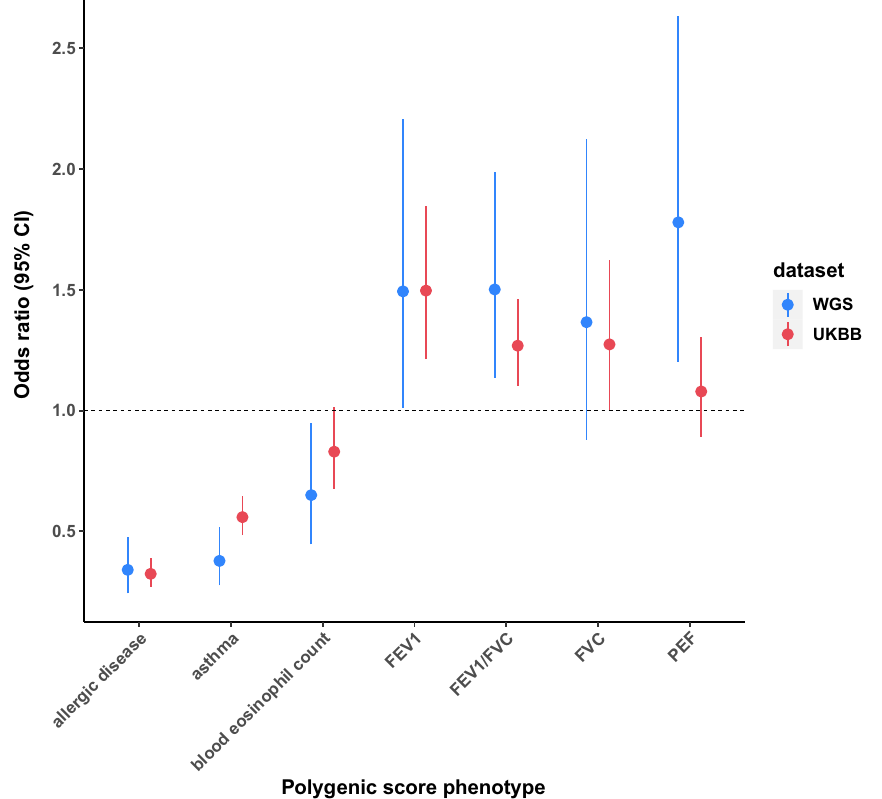
Figure 2. Association of polygenic scores with asthma age of onset. Childhood onset asthma was defined as age onset ≤ 12 and adult onset asthma was defined as age of onset ≥ 25. This binary age of onset trait was regressed on polygenic scores of various traits. Polygenic scores were calculated from publicly available GWAS of allergic disease (n = 242,569), asthma (n = 127,669), blood eosinophil cell counts (n = 40,521) and various lung function measures (n = 400,102). The analysis was carried out in the current whole-genome-sequencing cohort (WGS) (n = 1456) as well as in a cohort of UK Biobank participants (n = 6312). Increased polygenic scores for asthma, allergic disease and blood eosinophil counts are associated with younger age of onset, while increased lung function polygenic scores generally associate with adult onset asthma. Association statistics for PS analyses are available in Supplementary Table